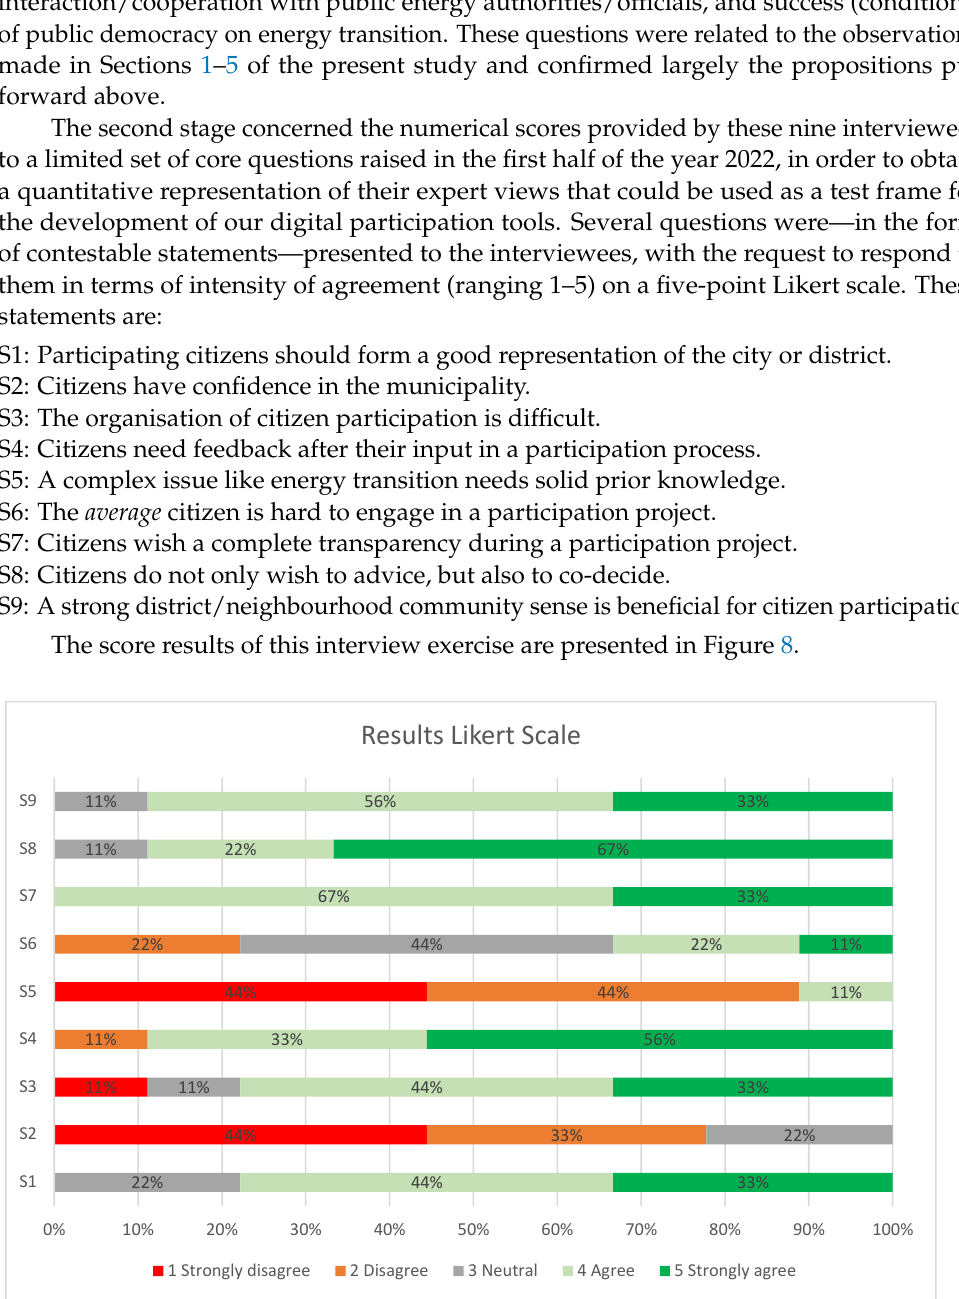
Figure 8. Score results of nine energy knowledge brokers on nine critical items on energy transition in Rotterdam.